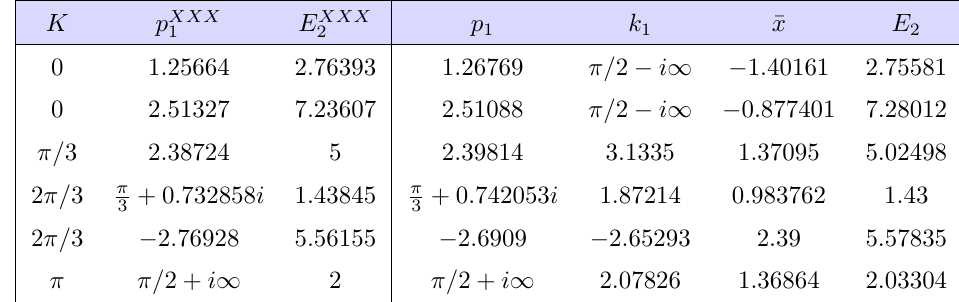
momenta can be found 2